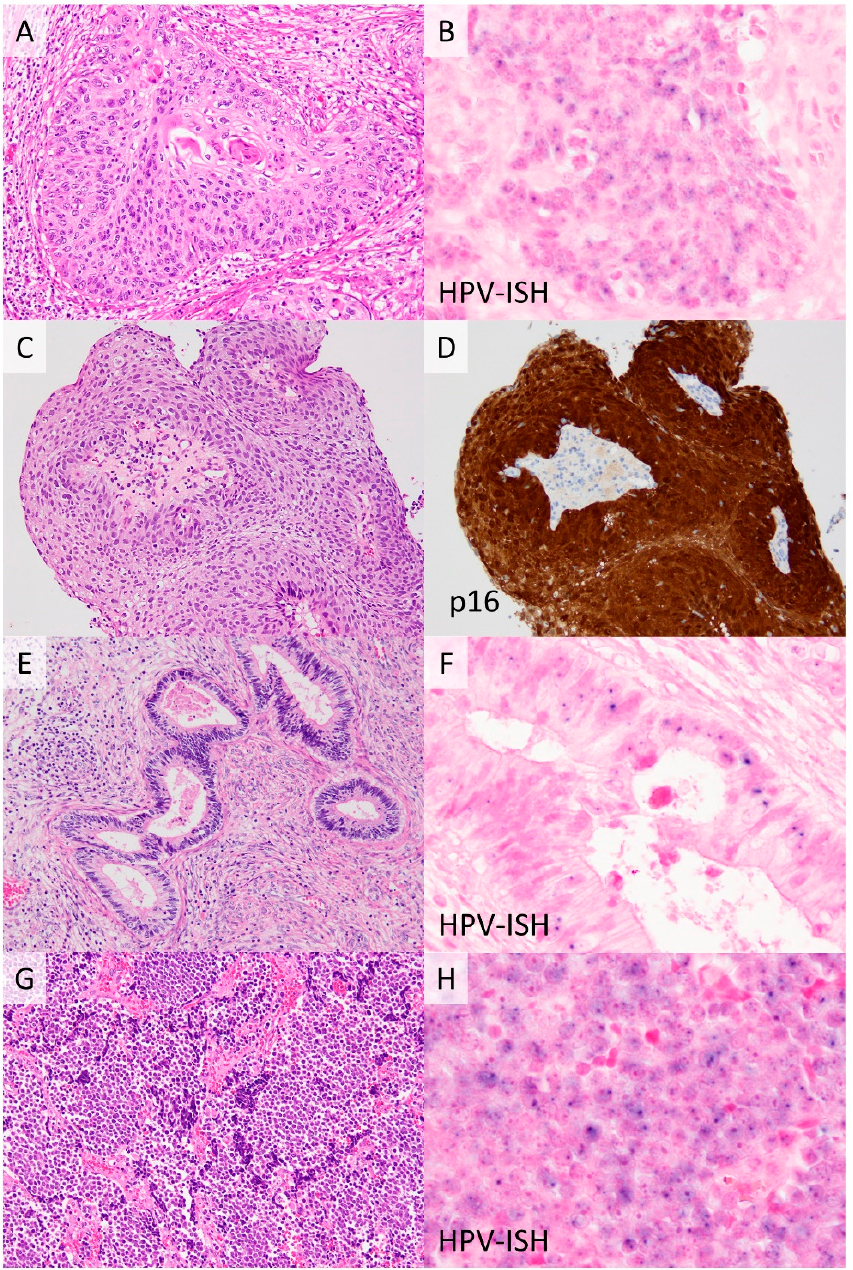
Figure 1. Representative histological types of human papillomavirus (HPV)-associated cervical can- cers. Squamous cell carcinoma ( A ) HPV in situ hybridization reveals small blue dot signals in tumor cells ( B ). Squamous cell carcinoma showing a so-called block positive pattern of p16 immunohisto- chemistry ( C , D ). Usual-type endocervical adenocarcinoma ( E ) shows HPV-positivity ( F ). Small cell neuroendocrine carcinoma ( G ) is reportedly HPV positive ( H ) in most cases. (( A , C , E , G ); H & E stain, ×200, ( D ), ×200 , ( B , F , H ), ×1000). Unlike SqCC, HPV-associated adenocarcinomas can be distinguished morphologi-